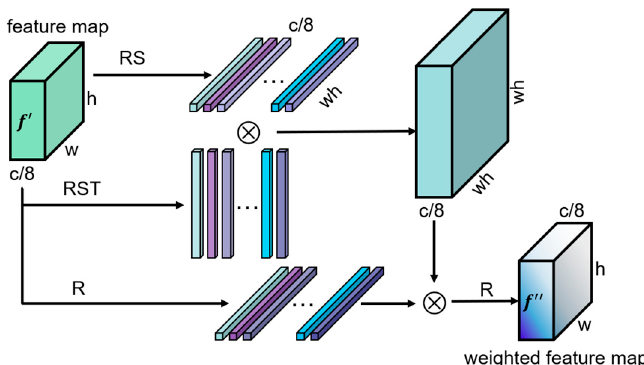
Figure 6. Correlation calculation layer in which the feature channels are separated.